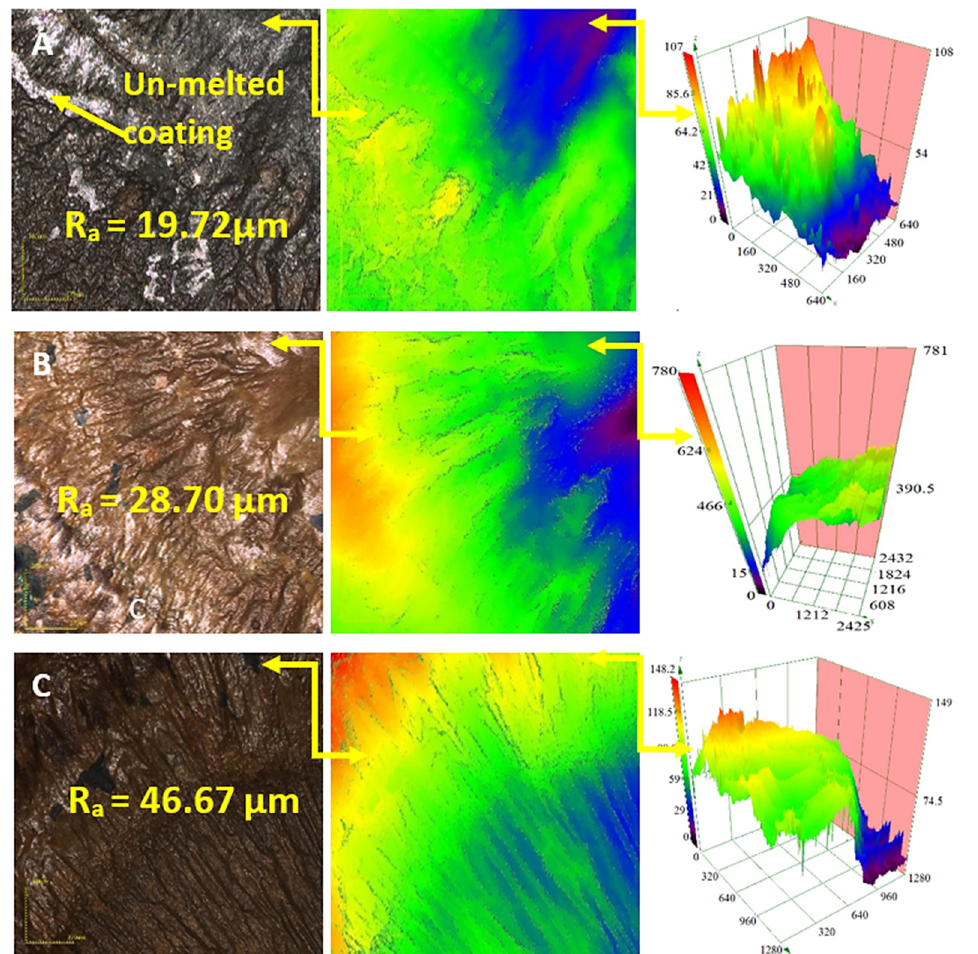
Figure 12. Confocal micrographs of the morphology of the treated Ti-6Al-4V coated with Ni / Al 2 O 3, including 250 nm diameter TiO 2 particles and melted as a function of welding current: ( A ) 50 A, ( B ) 75 A and ( C ) 100 A.